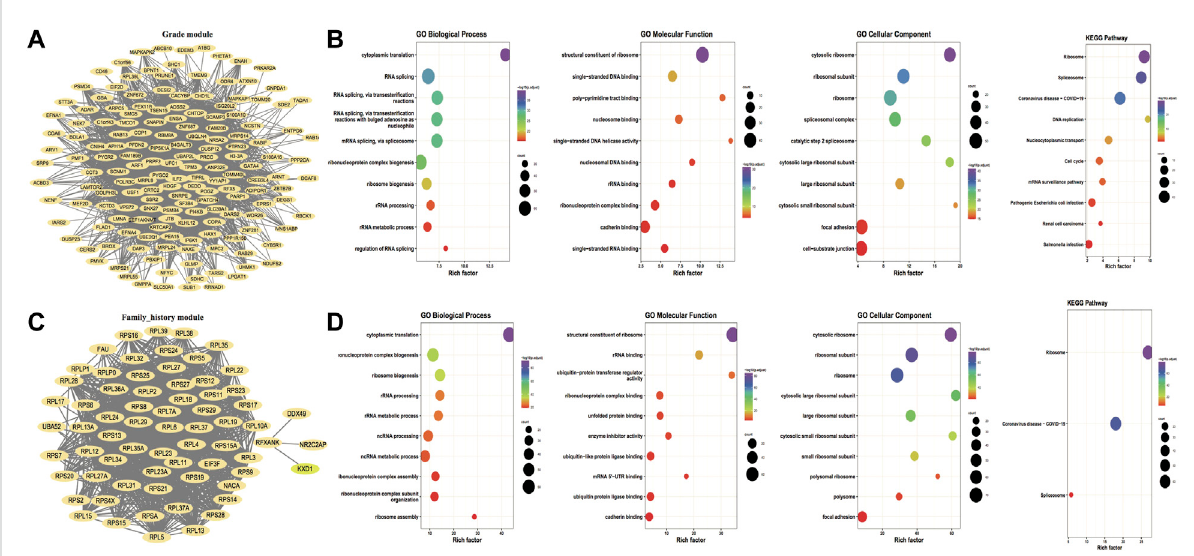
FIGURE 2 Hub gene co-expression network and hub gene enrichment analysis. (A,C) Co-expression network of hub genes for key traits grade and family_history, respectively, and the nodes of both FromNode and ToNode are selected for hub genes; (B,D) Functional enrichment analysis and KEGG pathway enrichment for key traits Grade and family_history, respectively. The dot ’ s size demonstrates the number of enriched hub genes and the color demonstrates the signi fi cance of